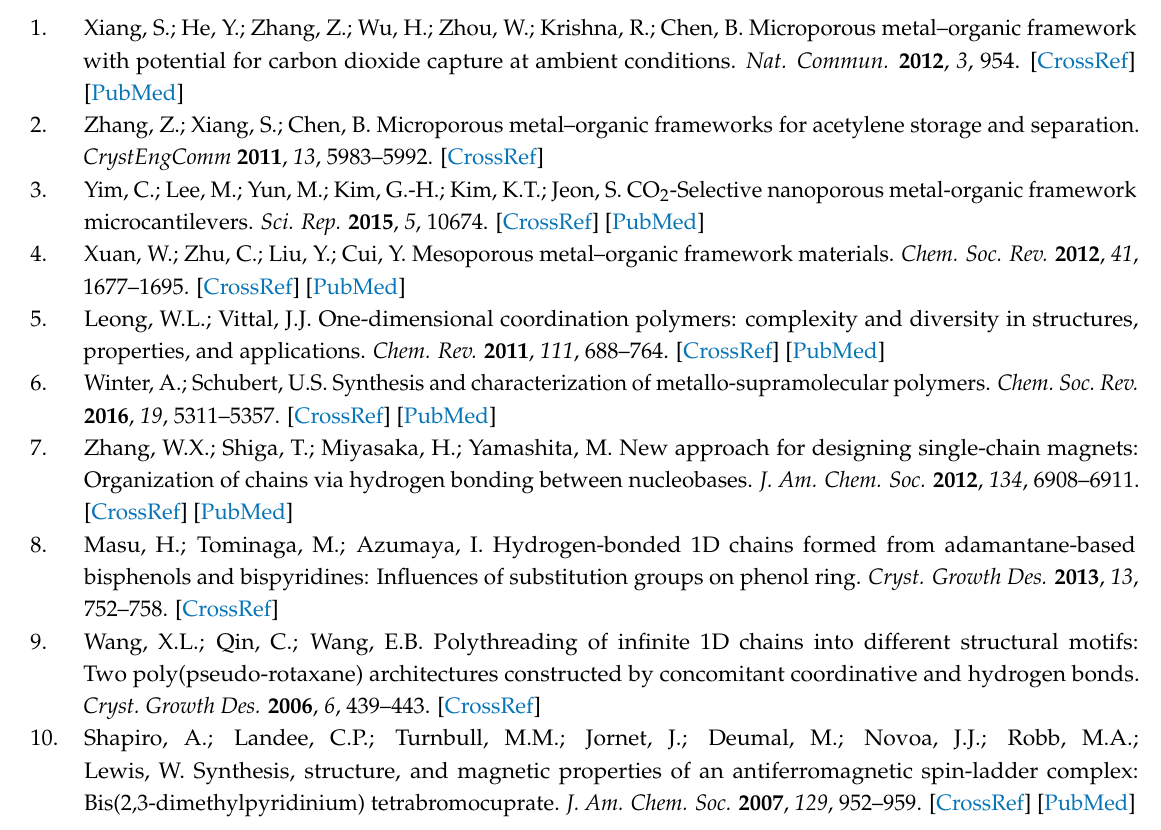
Figure S1: IR of copper acetate and the reported Cu(II)-dimer ... Cu(II)-monomer chain; Figure S2: